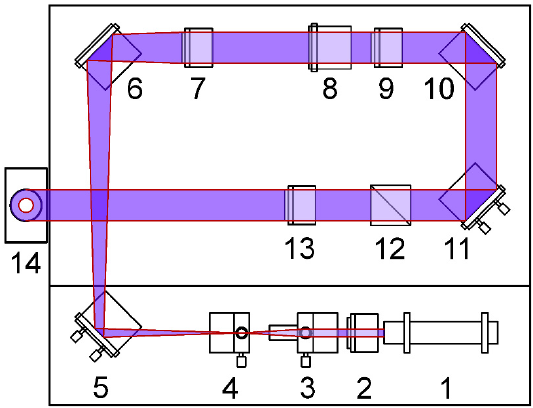
Figure 6. Optical scheme of KineMax: 1 is laser module, 405 nm, 50 mW, with a power supply unit and an electronic shutter, mounted on the optical plate; 2 is a quarter-wave plate; 3 is an objective; 4 is a pinhole aperture; 5 is a regulating mirror; 6 is an immobile mirror; 7 is an objective; 8 is a liquid crystal spatial light modulator (LC-SLM) 1024 × 768 pixels, 36.864 mm × 27.648 mm, the horizontal and vertical pixel period 36 µm; 9 is a lens; 10 is an immobile mirror; 11 is a regulating mirror; 12 is a beam splitting polarization cube; 13 is a quarter-wave plate; and 14 is an objective with a low spatial frequency filter.